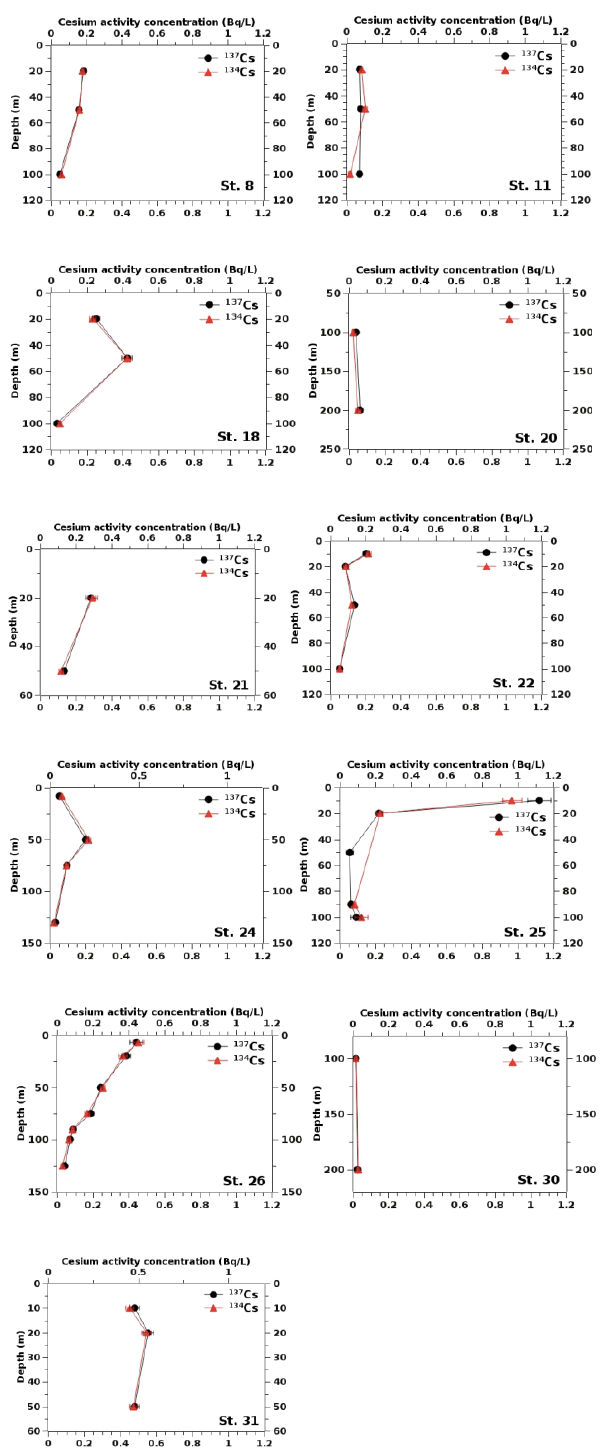
Fig. 6. 134 Cs and 137 Cs water profiles measured in the present work on samples collected during the KOK expedition. Positions of sam- pling stations are shown in Fig. 5.